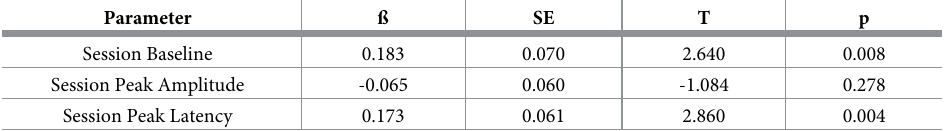
Table 2. Modeling the relationship between pupil features and IQR indicates that baseline and peak latency are associated with the distribution of response time between sessions in this longitudinal study.